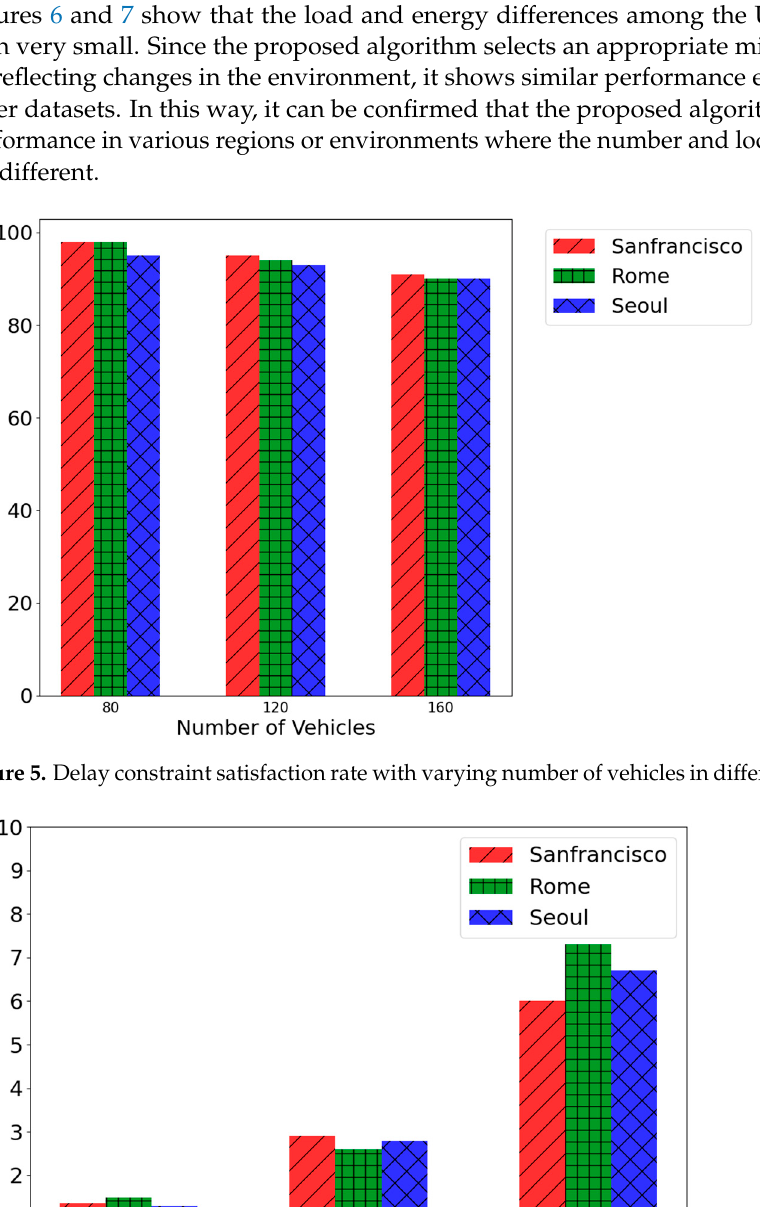
Figure 4. Residual energy deviation of UAV MECSs with varying number of vehicles.